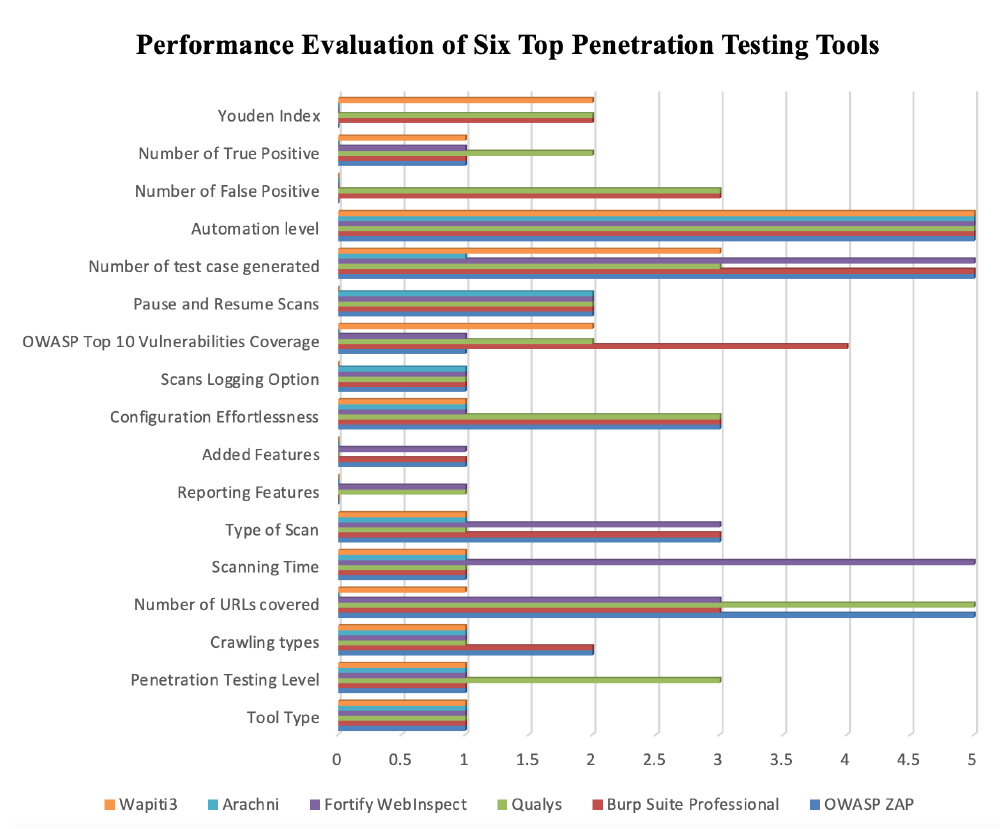
Figure 7. Evaluation performance of top 6 pen-testing